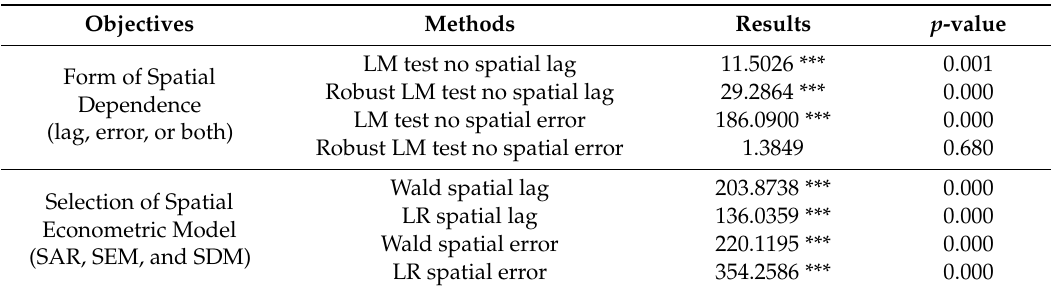
Table 4. Results of the Spatial Econometric Model Test.